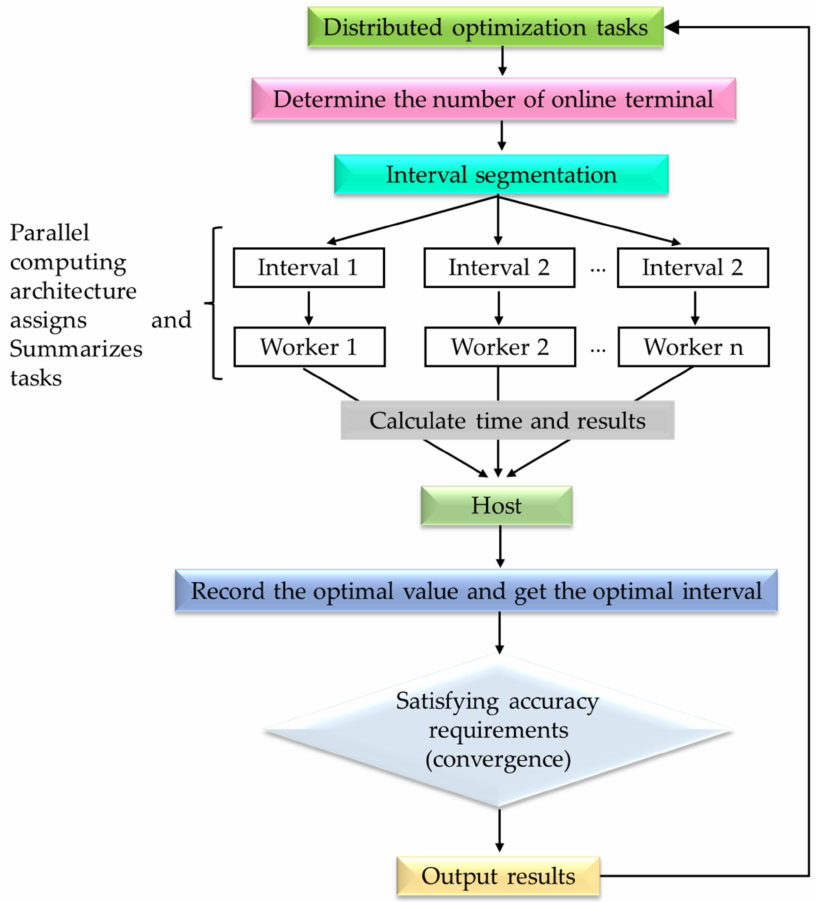
Figure 7. Process flow chart of parallel computing of NPSOPC (reprinted with permission from Ref. [61]. Copyright 2022